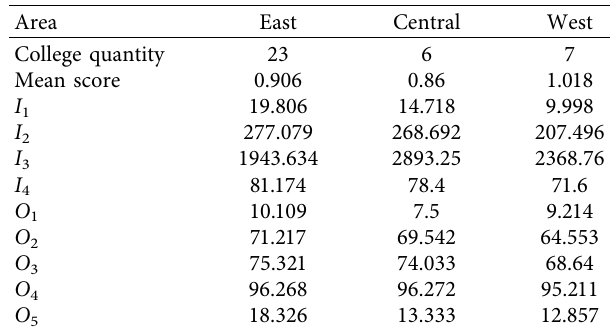
Table 6: The efficiency values and average indexes of universities of different regions of